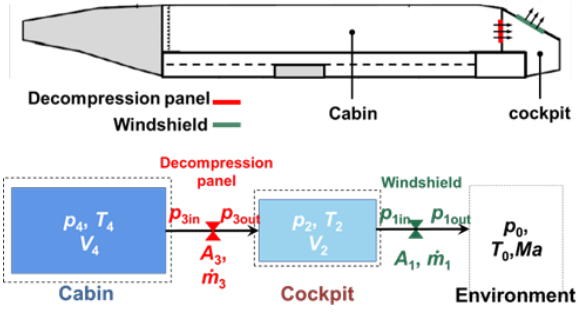
Figure 1. Schematic of the double-compartment model.